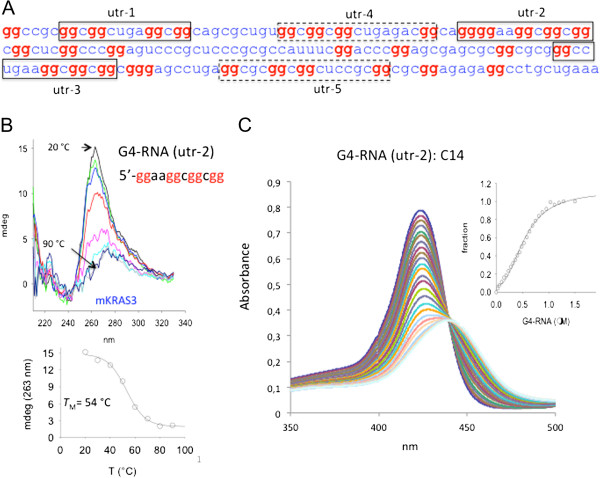
G4-RNA formation within 5′-UTR of ras mRNAs . (A) Sequence of 5′-UTR in the murine KRAS mRNA. The quadruplex-forming sequences (QFS) utr-1, utr-2, utr-3, utr-4 and utr-5 are boxed (strong QFS, full line; weak QFS broken line); (B) Typical CD spectra at various temperatures (from 20 to 90°C) of sequence utr2. Spectra have been collected at 20–30–40–50–60–70–80–90°C, using RNA 10 μM RNA, 50 mM Tris-HCl, pH 7.4, 100 mM KCl. The ordinate reports the CD values in mdeg. Graph below shows the CD-melting curve of the utr-2 G-quadruplex; (C) UV-vis titration of porphyrin C14 (6 μM) with quadruplex utr-2. Inset shows the fraction of bound C14 as a function of G4-RNA. The experimental points have been best fitted to a standard binding equation (Sigma Plot 11.0).